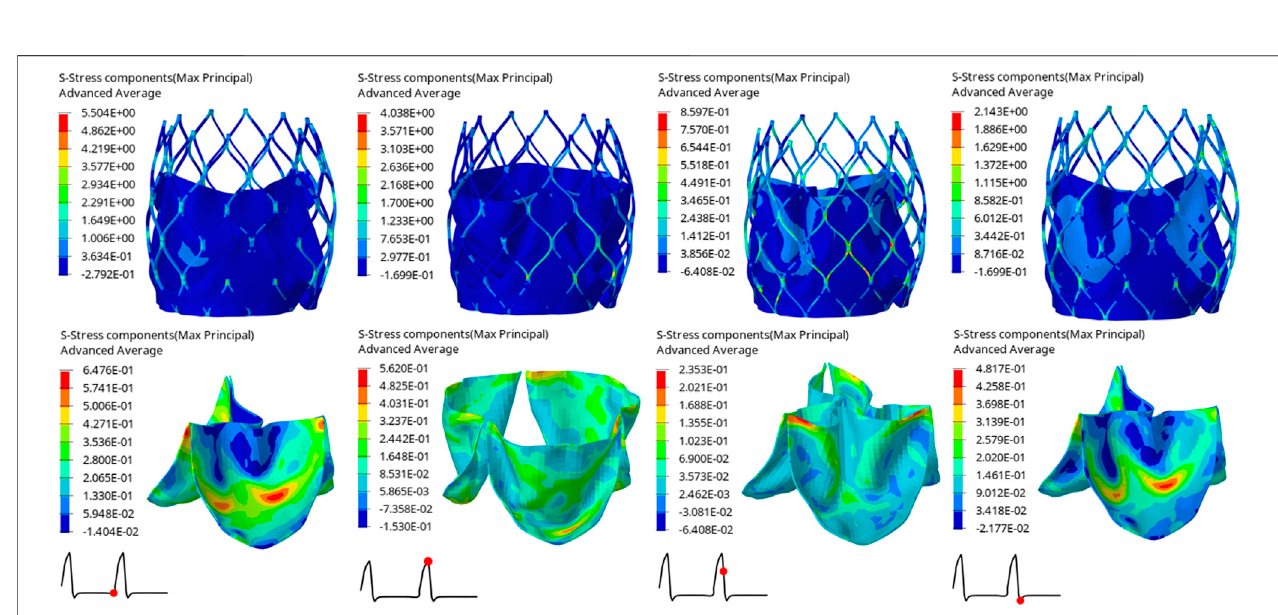
FIGURE 10 | Maximum principal stress distribution of valve stent and valve lea fl et of model B.